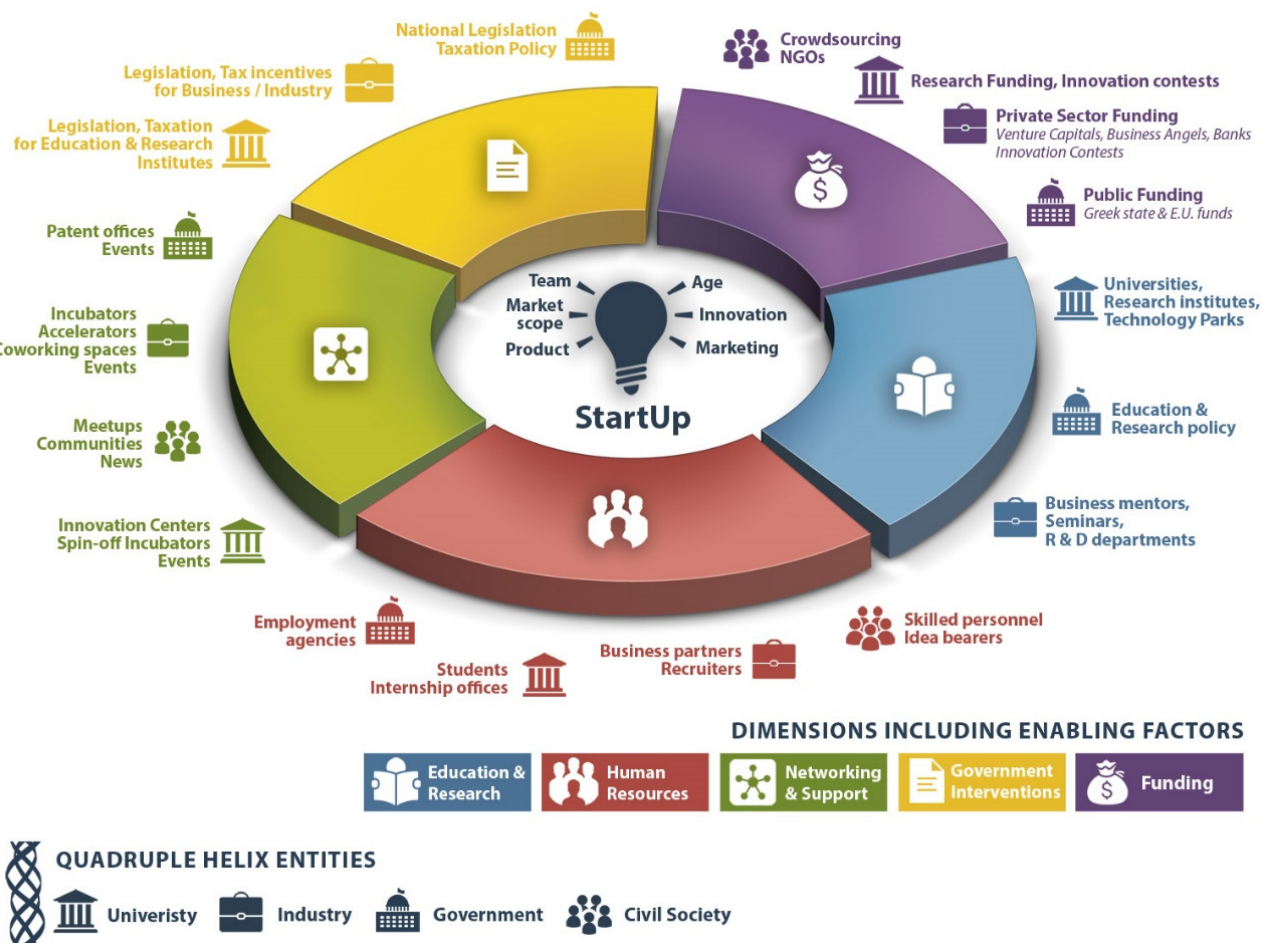
Figure 1. A quadruple helix approach on enabling factors of the Greek start-up ecosystem.